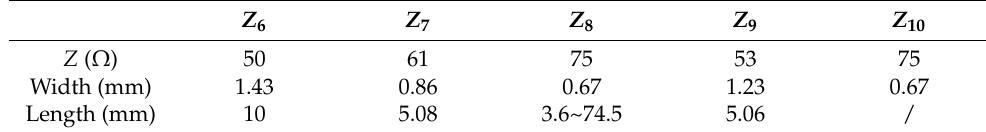
Table 3. Parameters of the bottom feeding network.